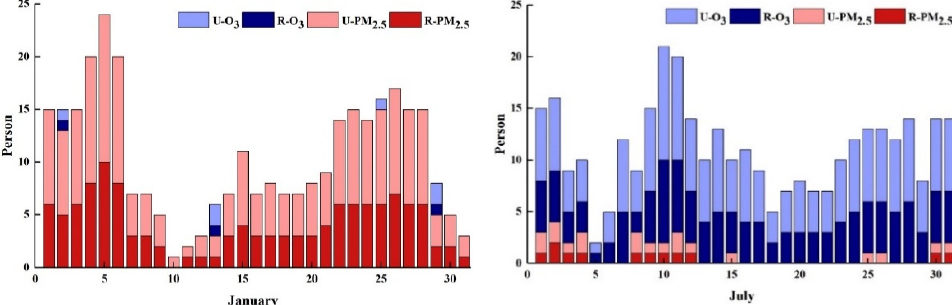
Figure 10. Health losses caused by PM 2.5 and O 3 in rural (R) and urban (U) areas of Chengdu in 2017.